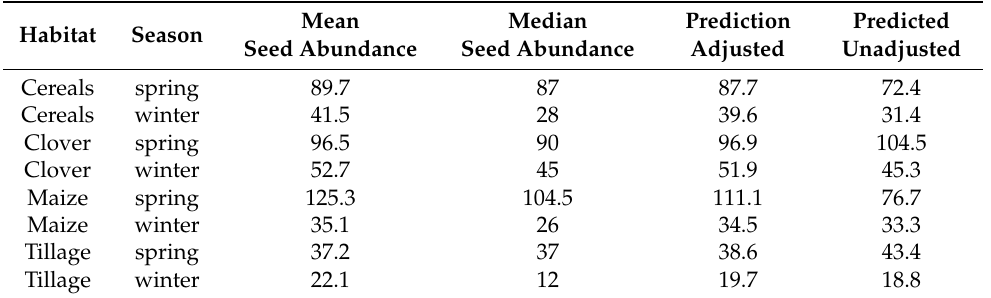
Table 7. Model predictions compared to seed abundance (mean and median) of the topsoil seed